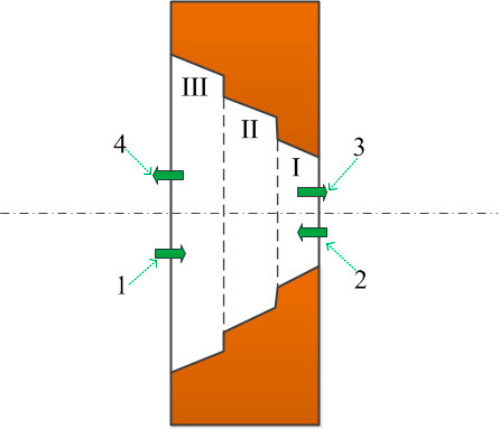
Figure 2. Flow channel of the micro-tapered hole.